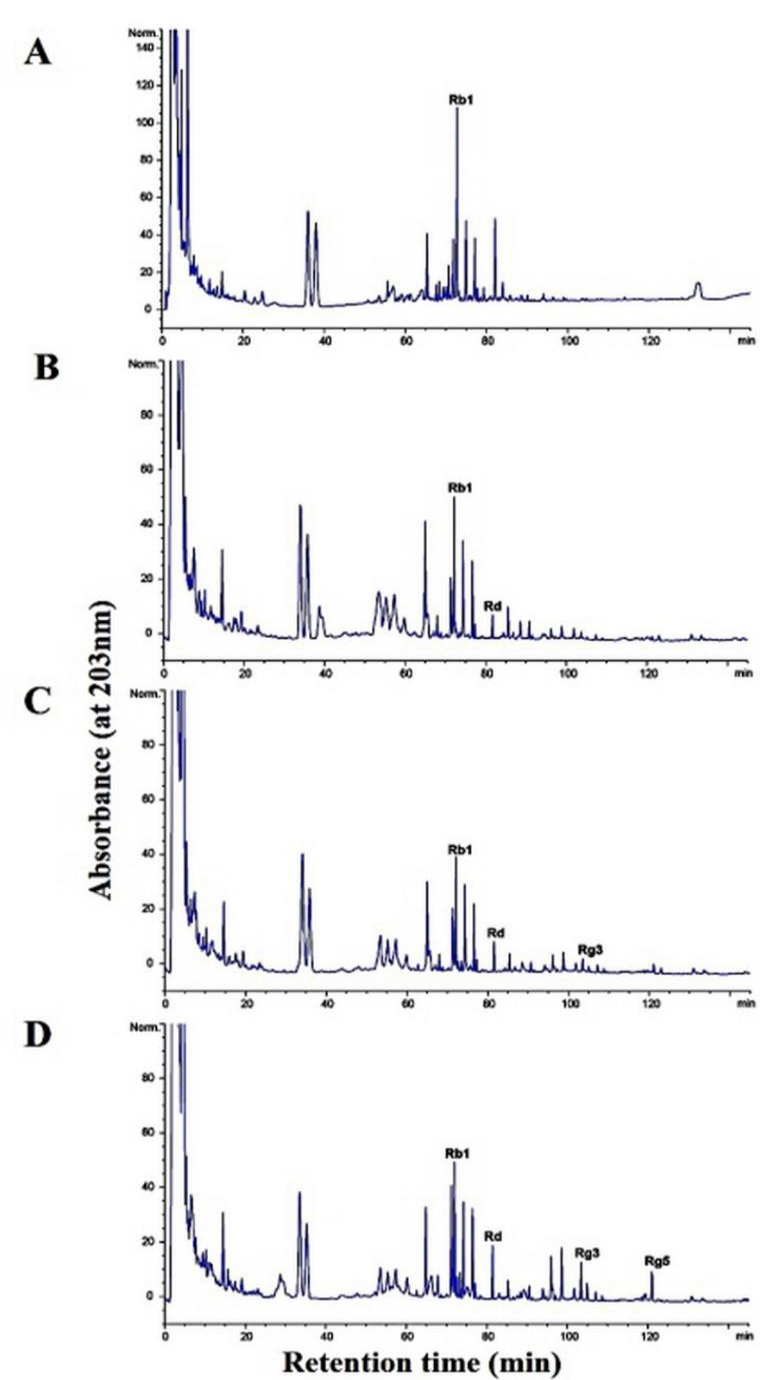
Figure 9. Ginsenoside conversion of ginseng root by Lentilactobacillus buchineri URN103L for fermen- tation: ( A ) Panax ginseng root; ( B ) 3 days; ( C ) 7 days; ( D ) 14 days. Ginsenoside Rg3, one of the saponins in American ginseng ( Panax quinquefolius L. Araliaceae), has been shown to inhibit tumor growth. The most affected pathway of anti- human colorectal cancer activity is the Ephrin receptor pathway in HCT-116 human colo- rectal cancer cells [30]. In radiation therapy combined with surgery or chemotherapy, Rg3 was applied to inhibit the growth of cancer cells [31]. In addition, there are reports of research on the anticancer activity of ginsenoside Rg3 in breast cancer [32,33], colon cancer